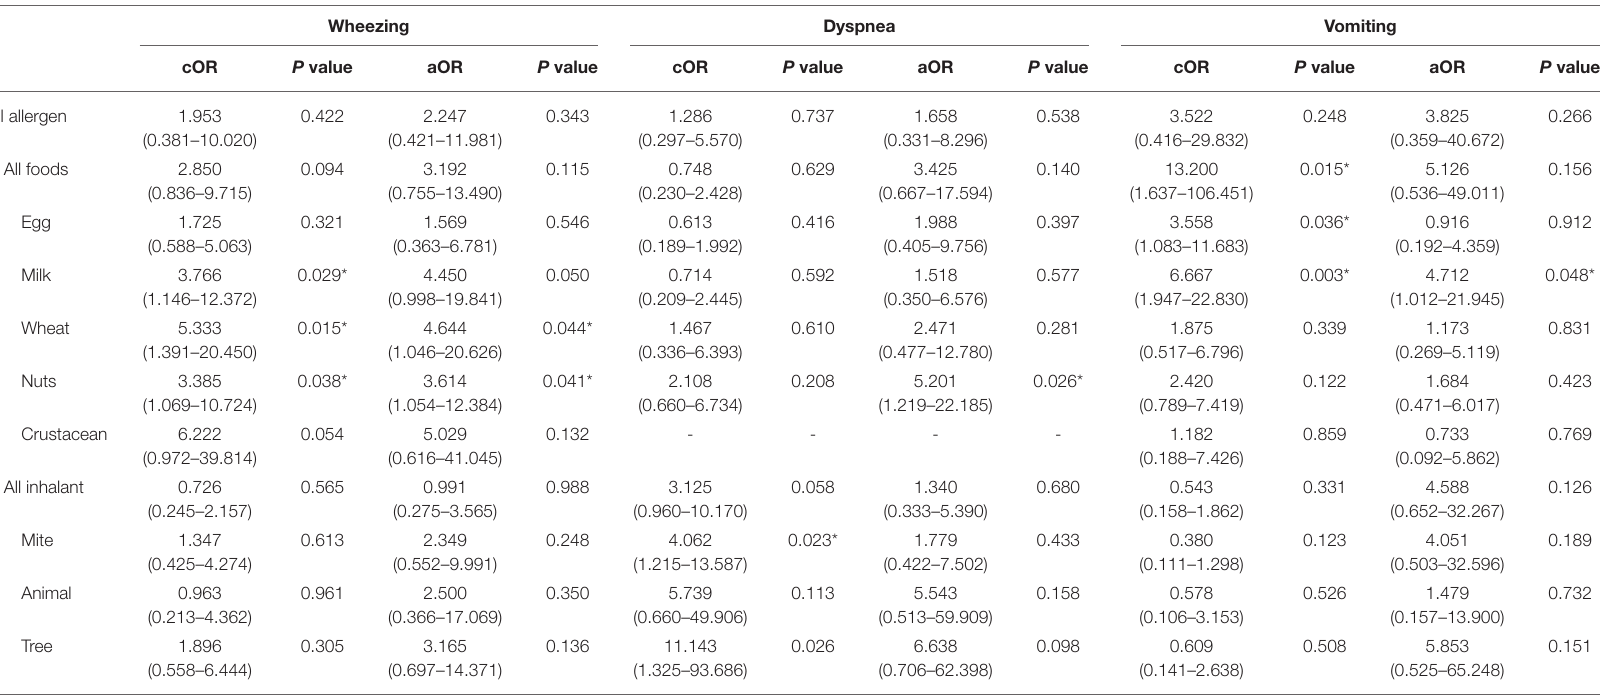
TABLE 4 | Logistic regression analysis of the association between the symptoms of anaphylaxis and the type of allergen sensitization ( n = 74). Wheezing